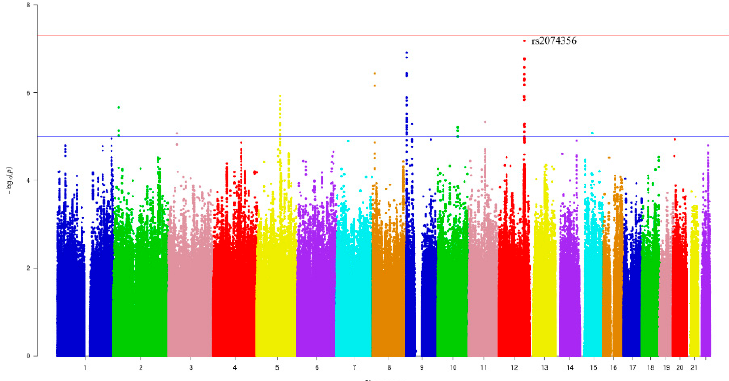
Figure 1. Manhattan plot of the genome-wide association study (GWAS) on coffee consumption. Each color represents a different chromosome. The strongest significant SNP was rs2074356 in chromosome 12 ( p -value = 6.62 × 10 − 8 ).